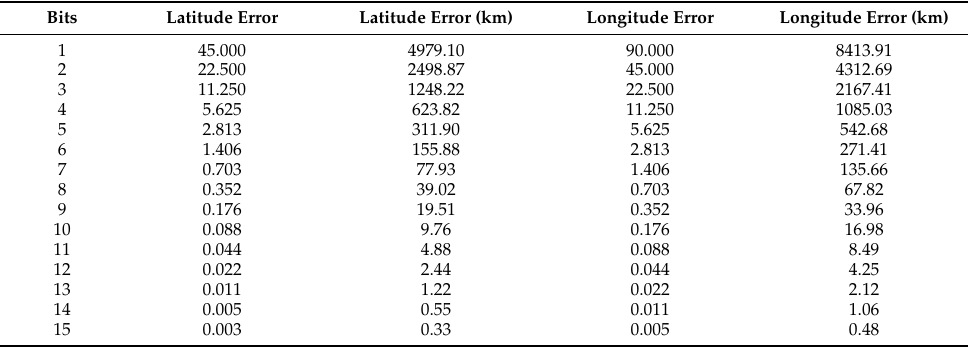
Table 1. Precision of binary geohash codes with various code lengths.